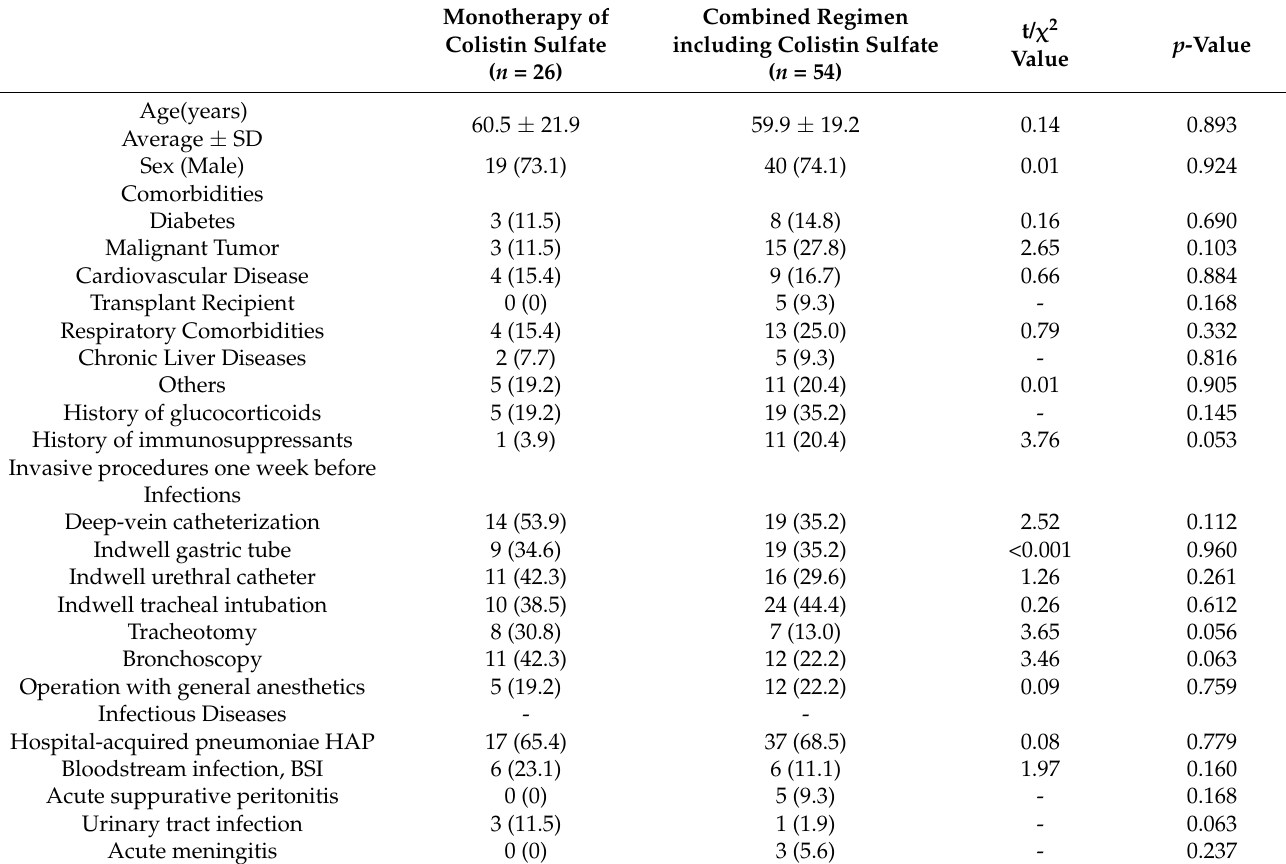
Table 1. Comparison of comorbidities between monotherapy and combination therapy groups.